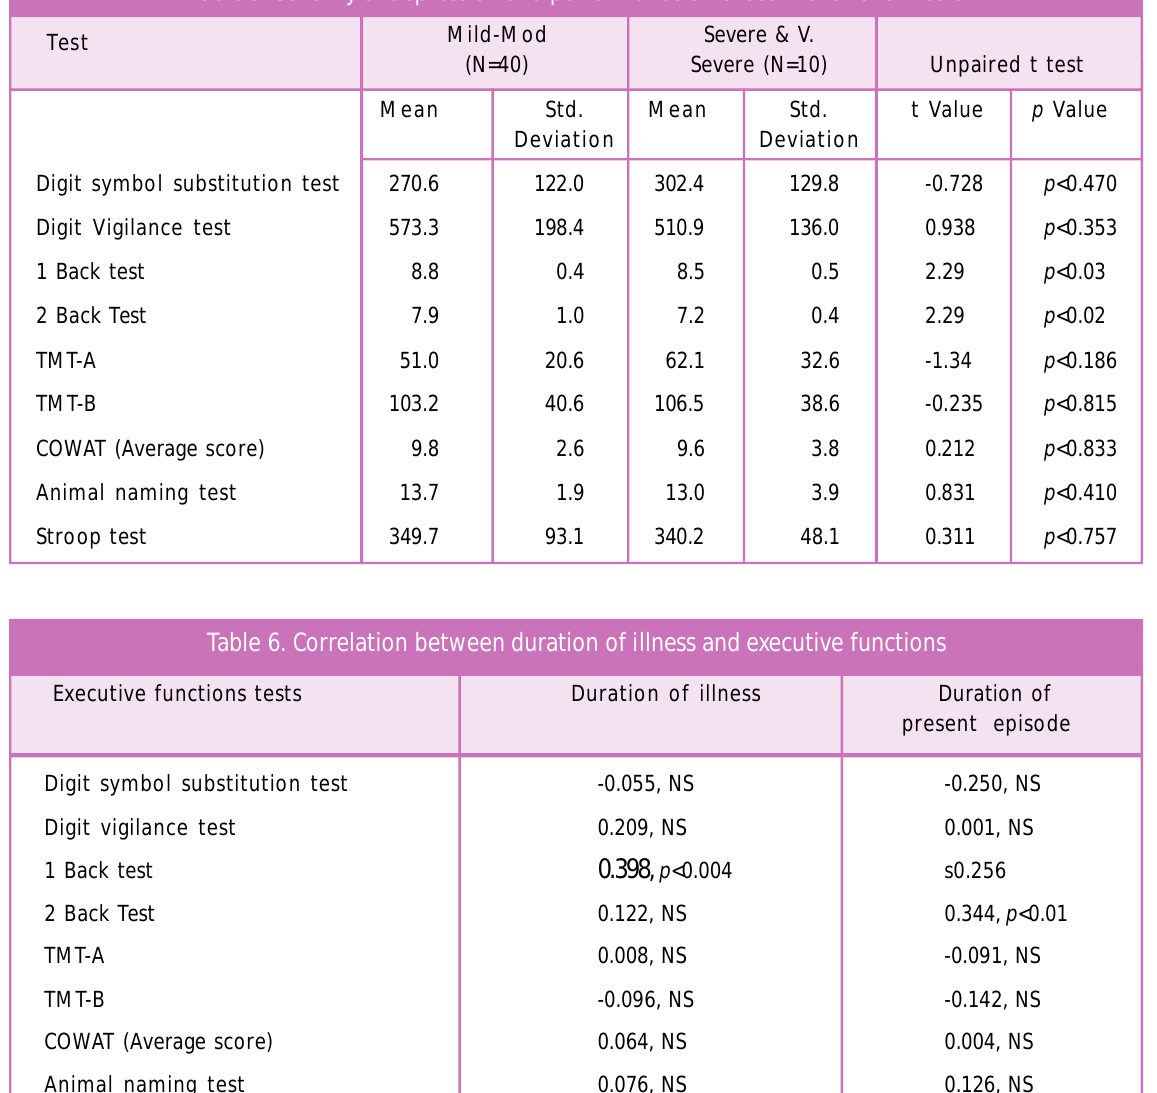
Table 5. Severity of depression and performance on executive function tests